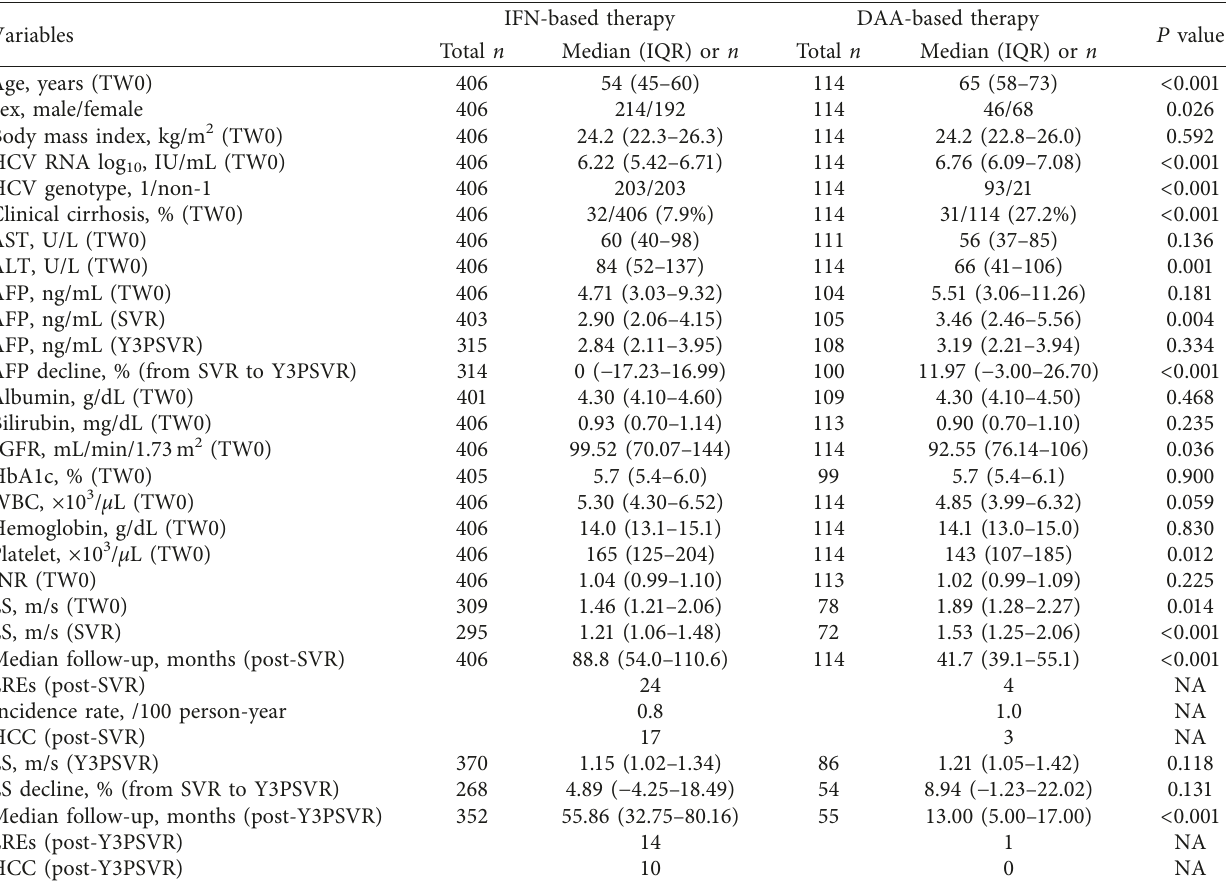
Table 1: Patient characteristics.